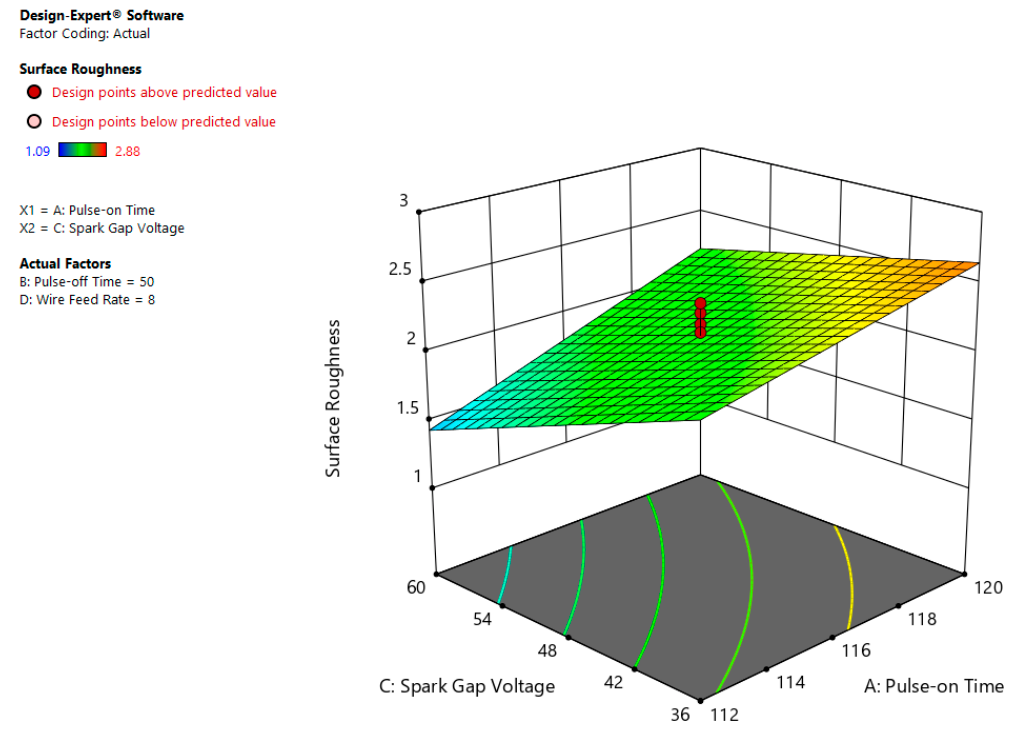
Figure 12. Interaction influence of Ton and SV on SR.